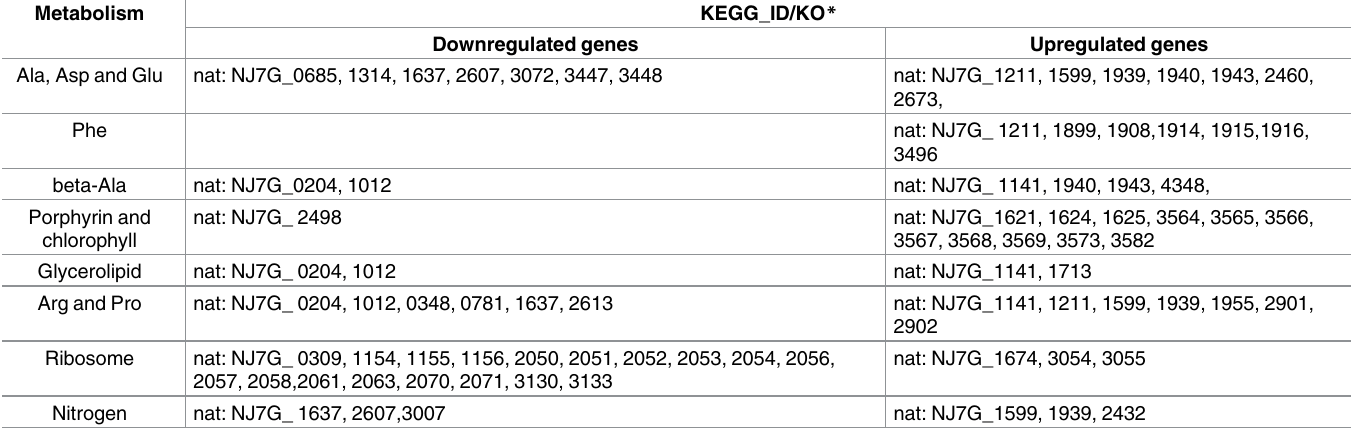
Table 1. KEGG pathway analysis of DEGs (Nat_15vs Nat_25).